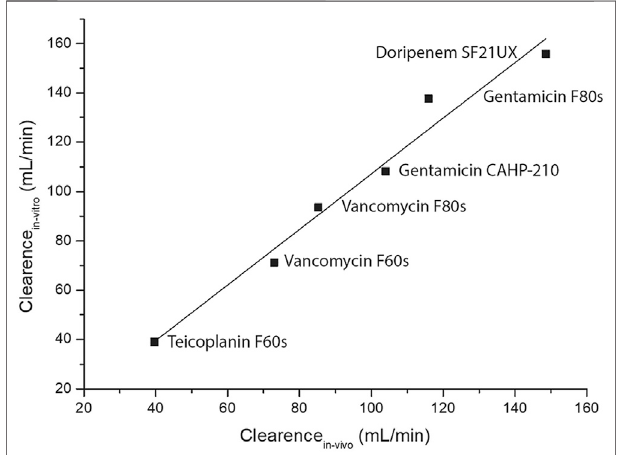
FIGURE 2 | Best- fi t straight-line correlation graph between previously published in vivo hemodialysis clearance rates and the corresponding results from the in vitro experiments. Number of Points 6, Degrees of Freedom 4, Residual Sum of Squares 2,43,25,364, Pearson ’ s r, 0,98667, Adj. R-Square